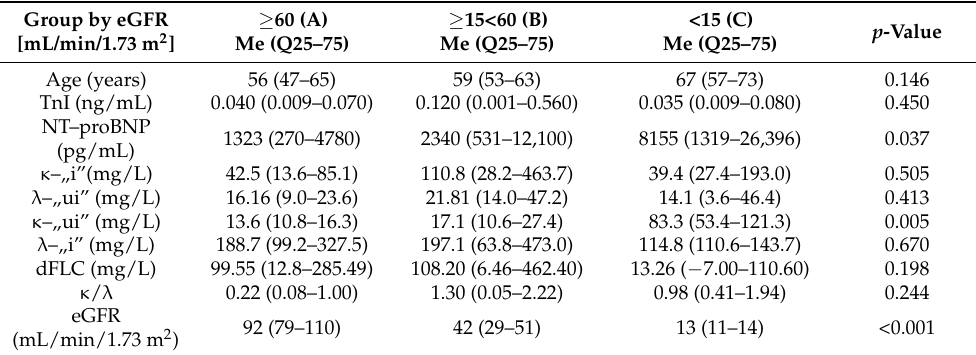
Table 2. The comparative analysis of the study group depending on the stage of chronic kidney disease (CKD) according to Kidney Disease: Improving Global Outcomes (KDIGO) CKD Work Group: KDIGO